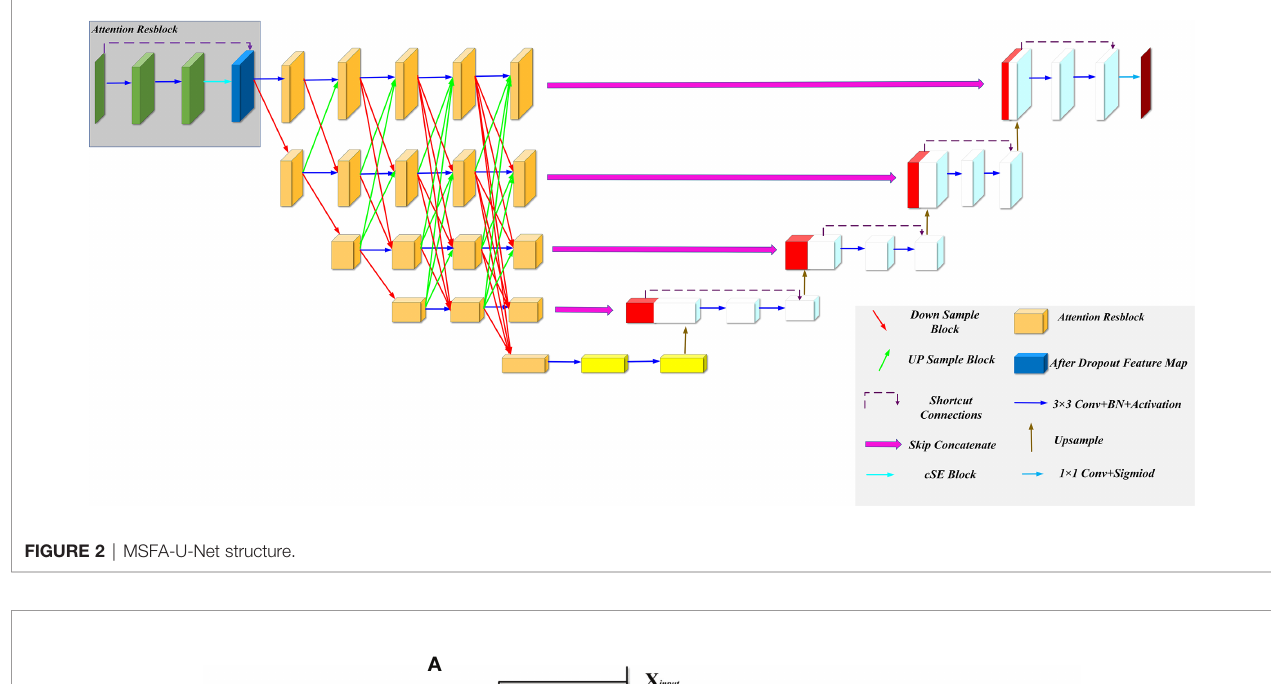
FIGURE 2 | MSFA-U-Net structure.